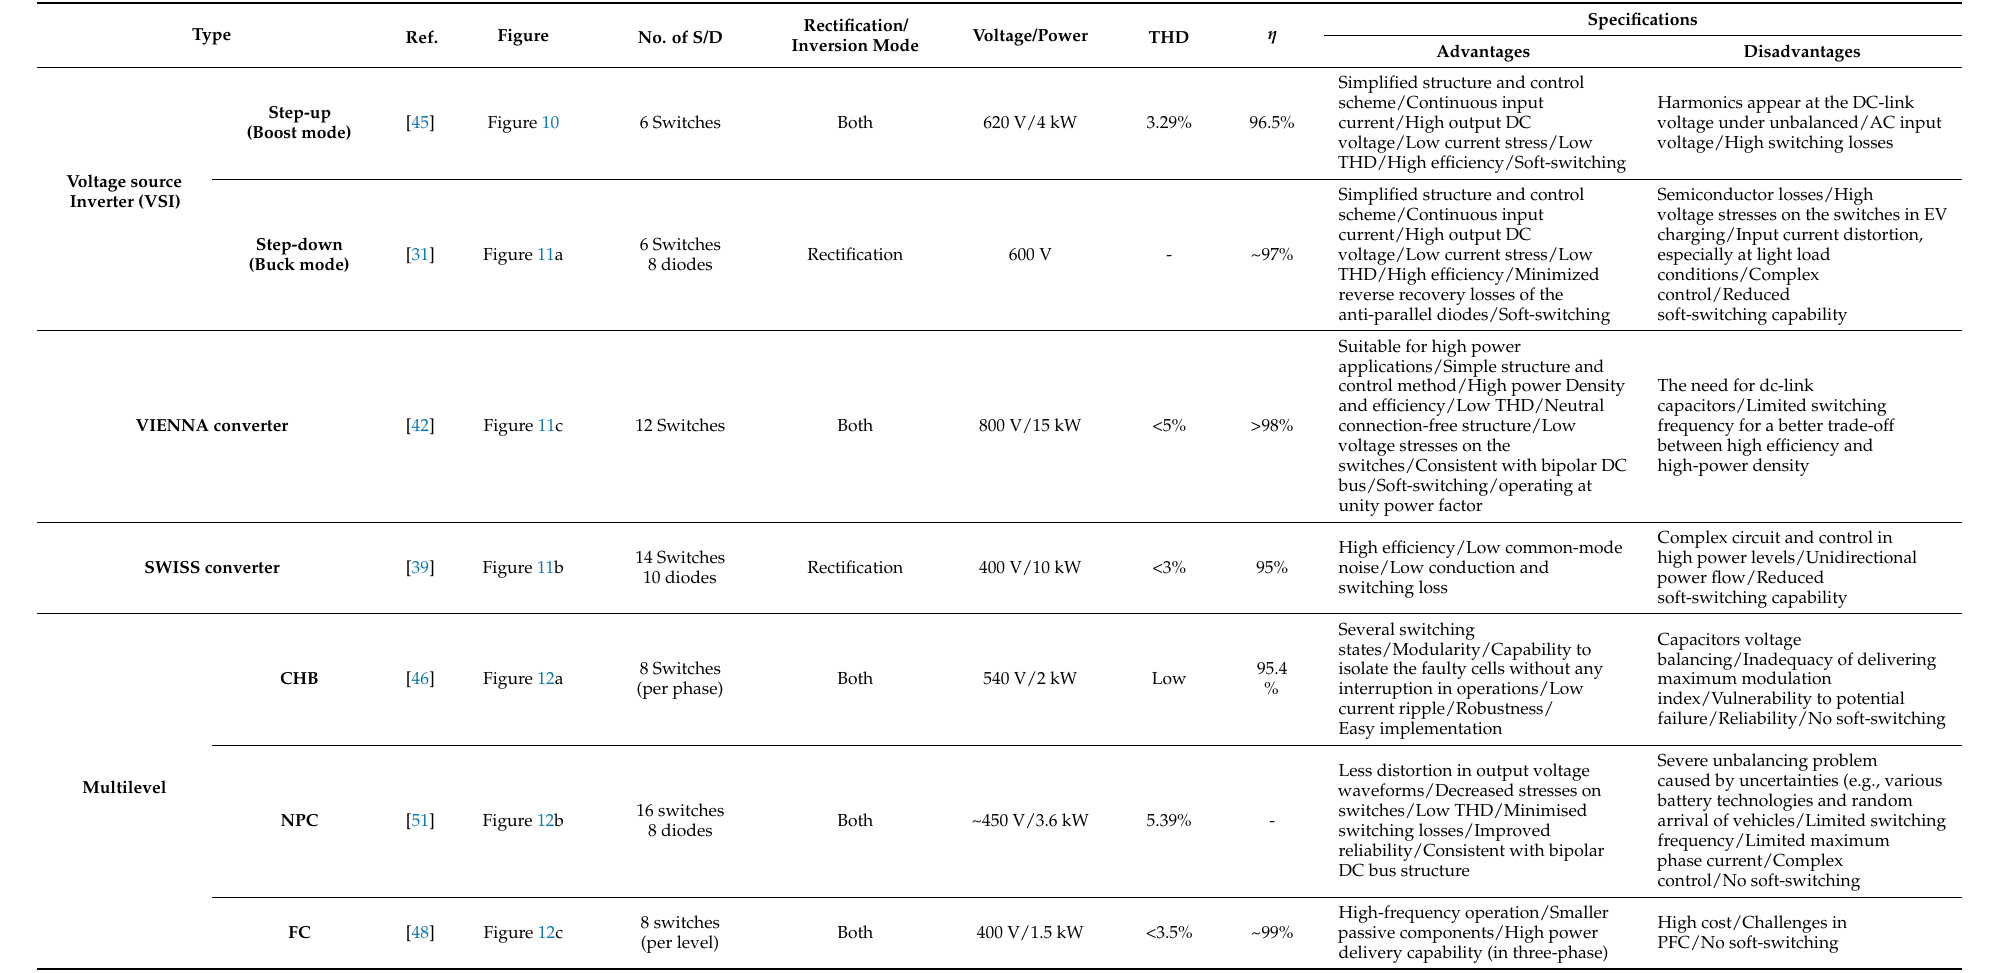
Table 4. A technical comparison among grid-interfaced converter